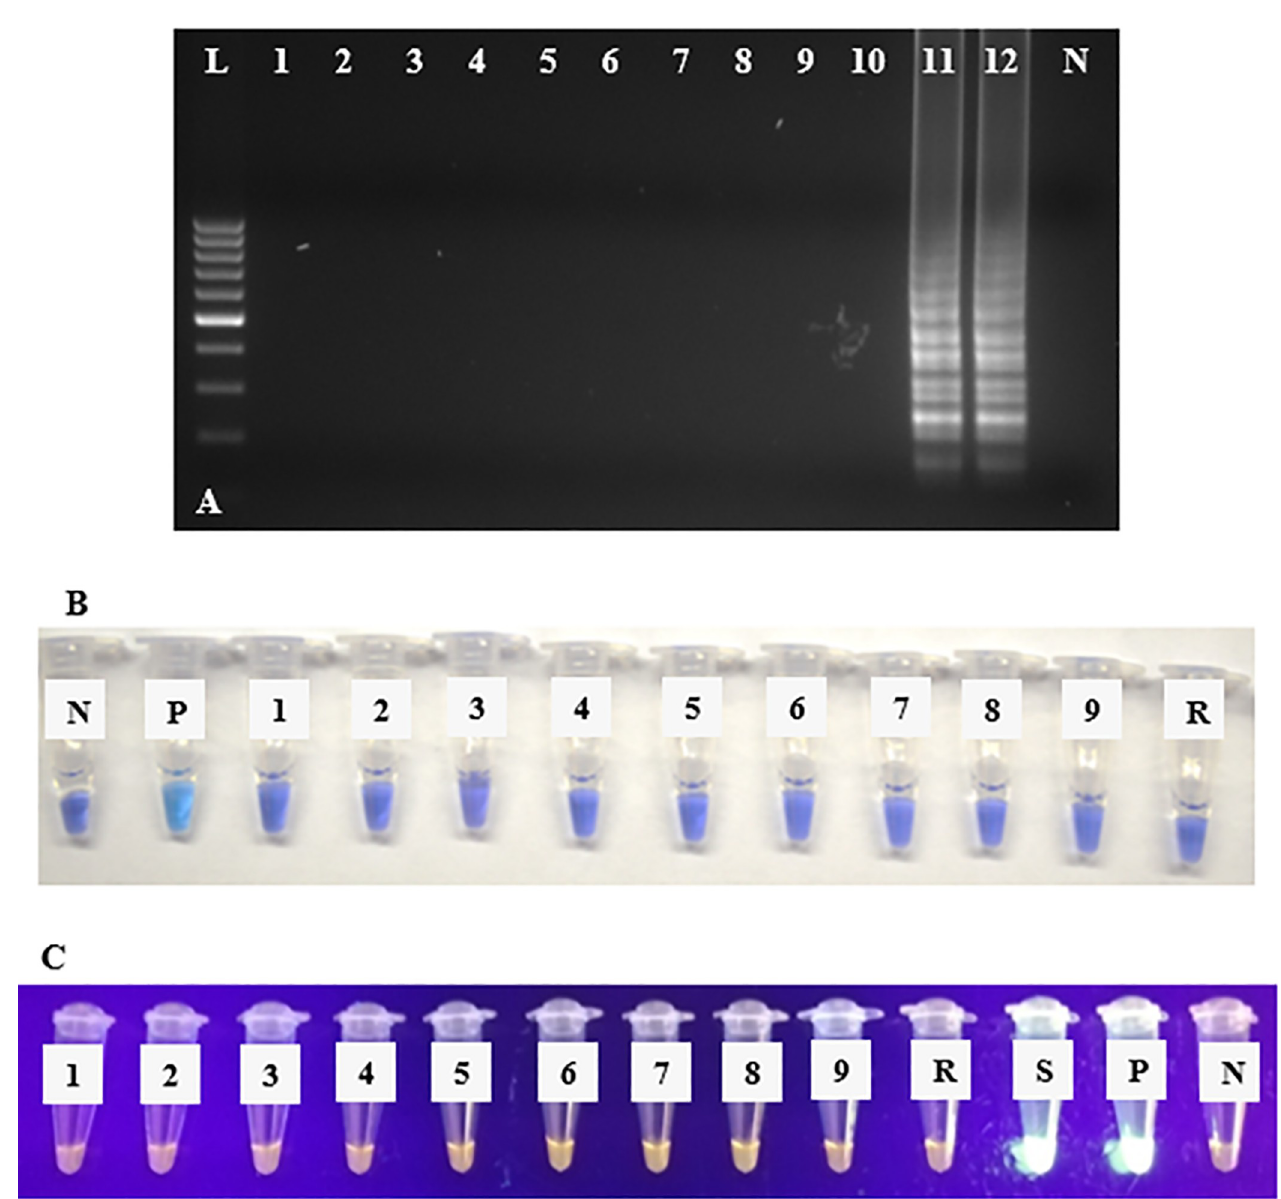
Fig 8. RRV-P3 RT-LAMP specificity assays using Bst 2.0 WarmStart DNA polymerase with cDNA from nine reference viruses and controls. RRV-P3 and RRV-P4 RT-LAMP results are equal. (A) Agarose gel electrophoresis of RT-LAMP products. Lane L, is a 100 bp DNA ladder, lane 1 is INSV, lane 2 is HPWMoV, lane 3 is ArMV, lane 4 is MSpV, lane 5 is TSWV, lane 6 is ApMV, lane 7, is PNRSV, lane 8 is ToRSV, lane 9 TMV (full virus names were provided in the main text for the reference viruses), lane 10 is healthy rose tissue, lane 11 is RRV symptomatic rose tissue, lane 12 is RRV-P3 plasmid, lane N is non- template control (NTC, water). (B) Colorimetric RRV-P3 RT-LAMP specificity assay using HNB using cDNA of nine reference control viruses. Tube N, is a non-template control (NTC, water), tube P is RRV-P3 plasmid, tube 1 is INSV, tube 2 is HPWMoV (formerly High plain virus), tube 3 is ArMV, tube 4 is MSpV, tube 5 is TSWV, tube 6 is ApMV, tube 7 is PNRSV, tube 8 is ToRSV, tube 9 TMV (full virus names were provided in the main text for the reference viruses), tube R, healthy rose tissue. (C) Colorimetric RRV-P3 RT-LAMP specificity assay using SYBR Green I. tube 1 is INSV, tube 2 is HPWMoV, tube 3 is ArMV, tube 4 is MSpV, tube 5 is TSWV, tube 6 is ApMV, tube 7, is PNRSV, tube 8 is ToRSV, tube 9 TMV (full virus names were provided in the main text for the reference viruses), tube R is healthy rose tissue, tube S is RRV symptomatic rose tissue, tube P is RRV-P3 plasmid, and tube N is a non-template control (NTC,